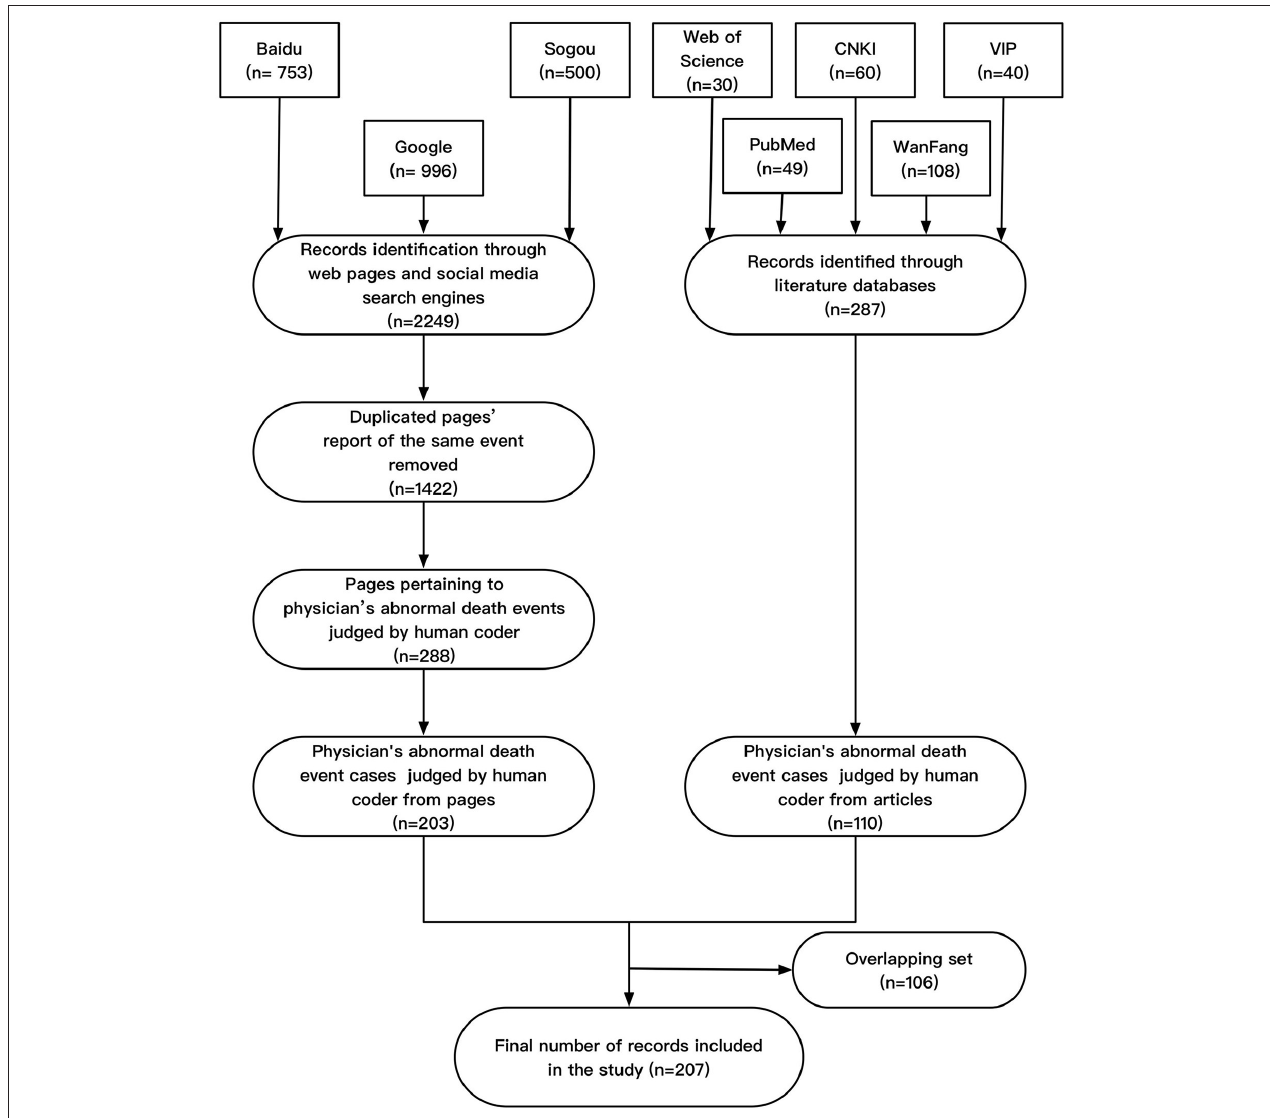
FIGURE 1 | Flow chart of the data retrieval